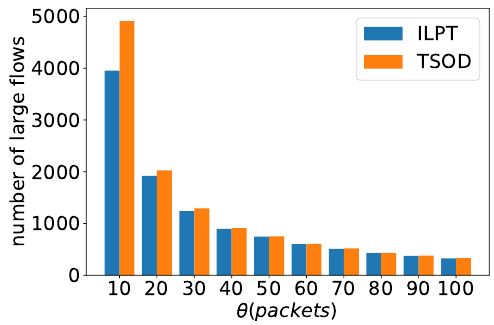
Figure 10. Number of large flows with different θ